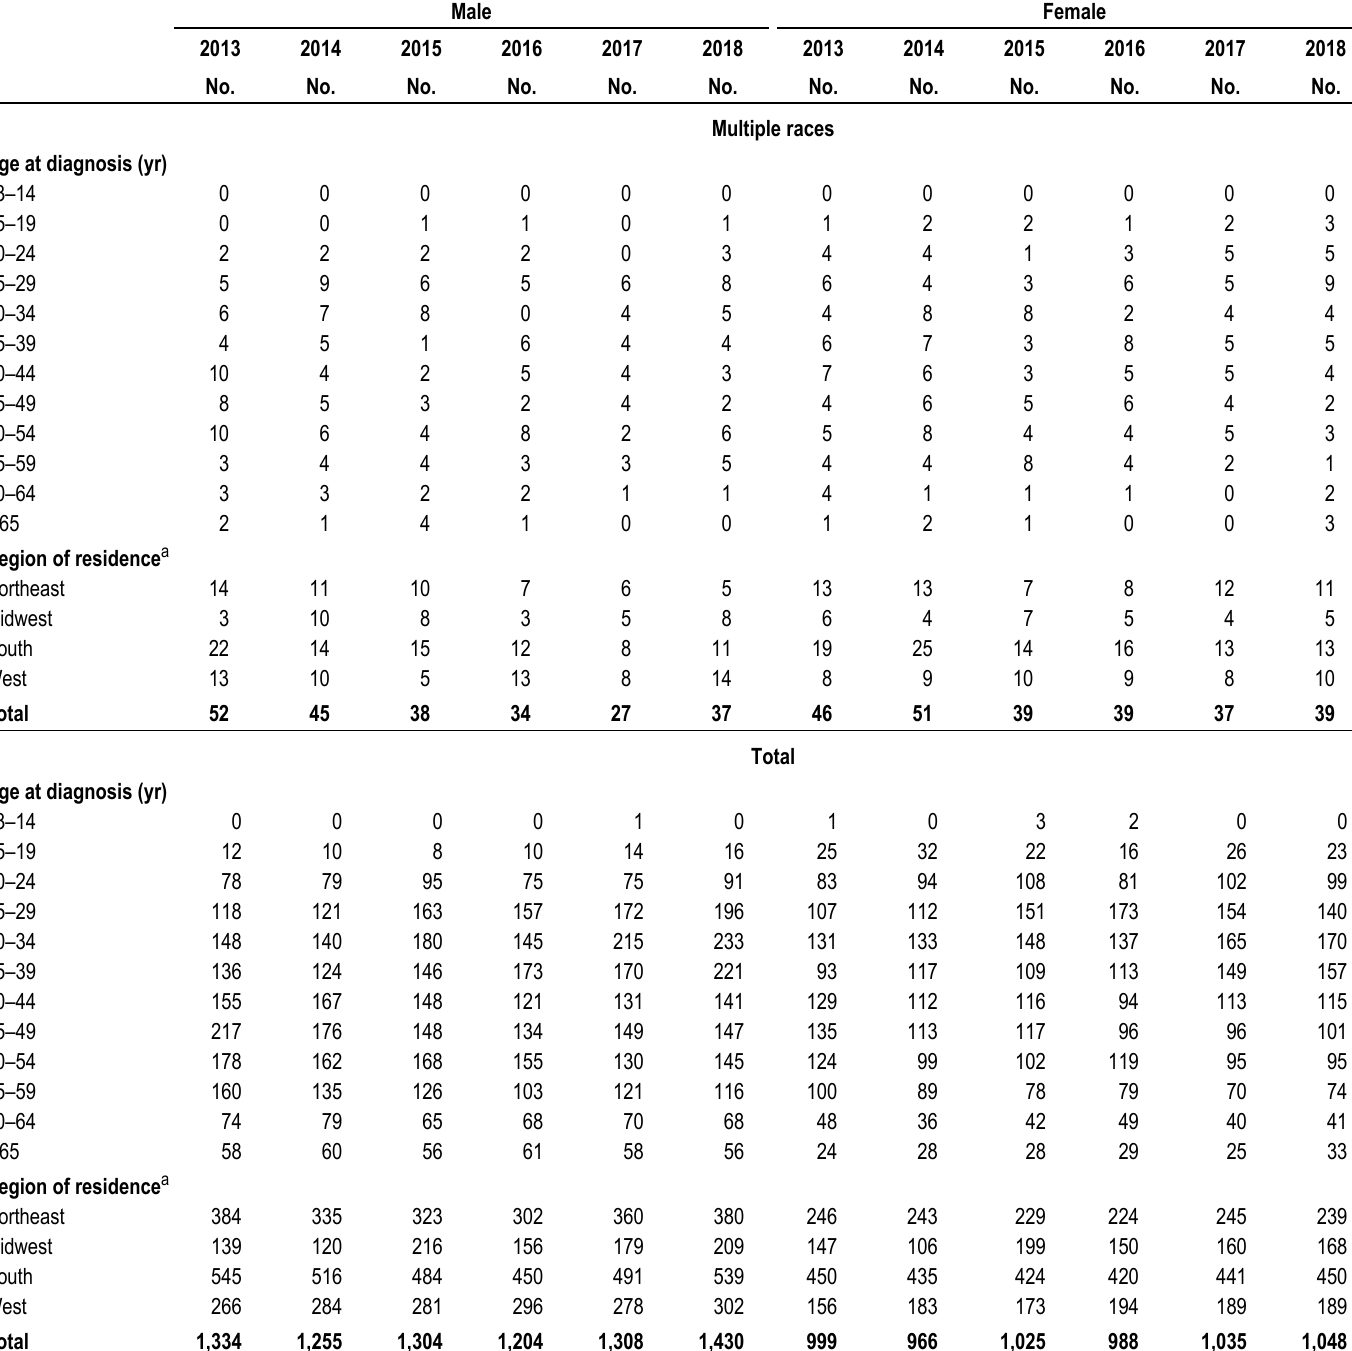
Table 8a. Diagnoses of HIV infection attributed to injection drug use, by selected characteristics, 2013–2018—United States (cont)